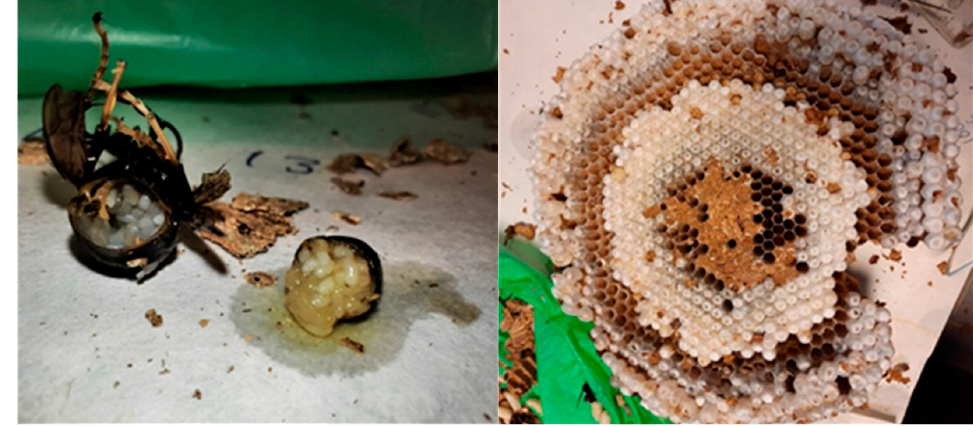
Figure 5. Mated queen (left) full of eggs and a comb with regular brood (right) in a mature secondary nest.